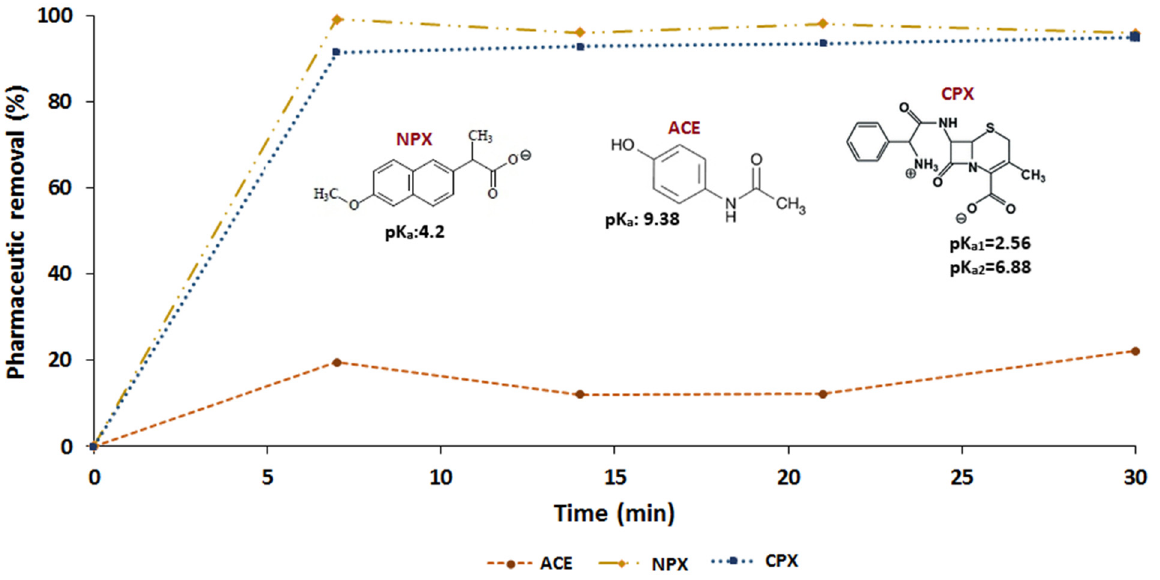
Figure 4. Adsorption of naproxen (NPX), acetaminophen (ACE), and cephalexin (CPX) on F Zn material. Adsorption conditions (pharmaceutic): 20 mg L − 1 ; adsorbent doses: 1.6 g L − 1 ; pH: 4.0–5.0.